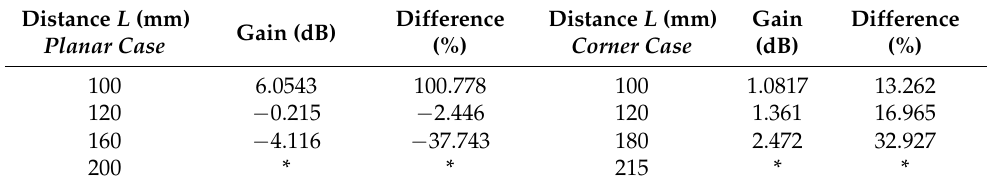
Difference of signal spectra amplitudes with respect to maximum distance (*—reference